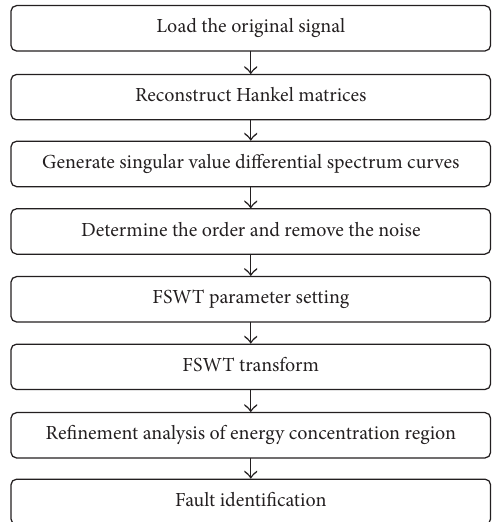
Figure 1: Flow chart of signal processing.